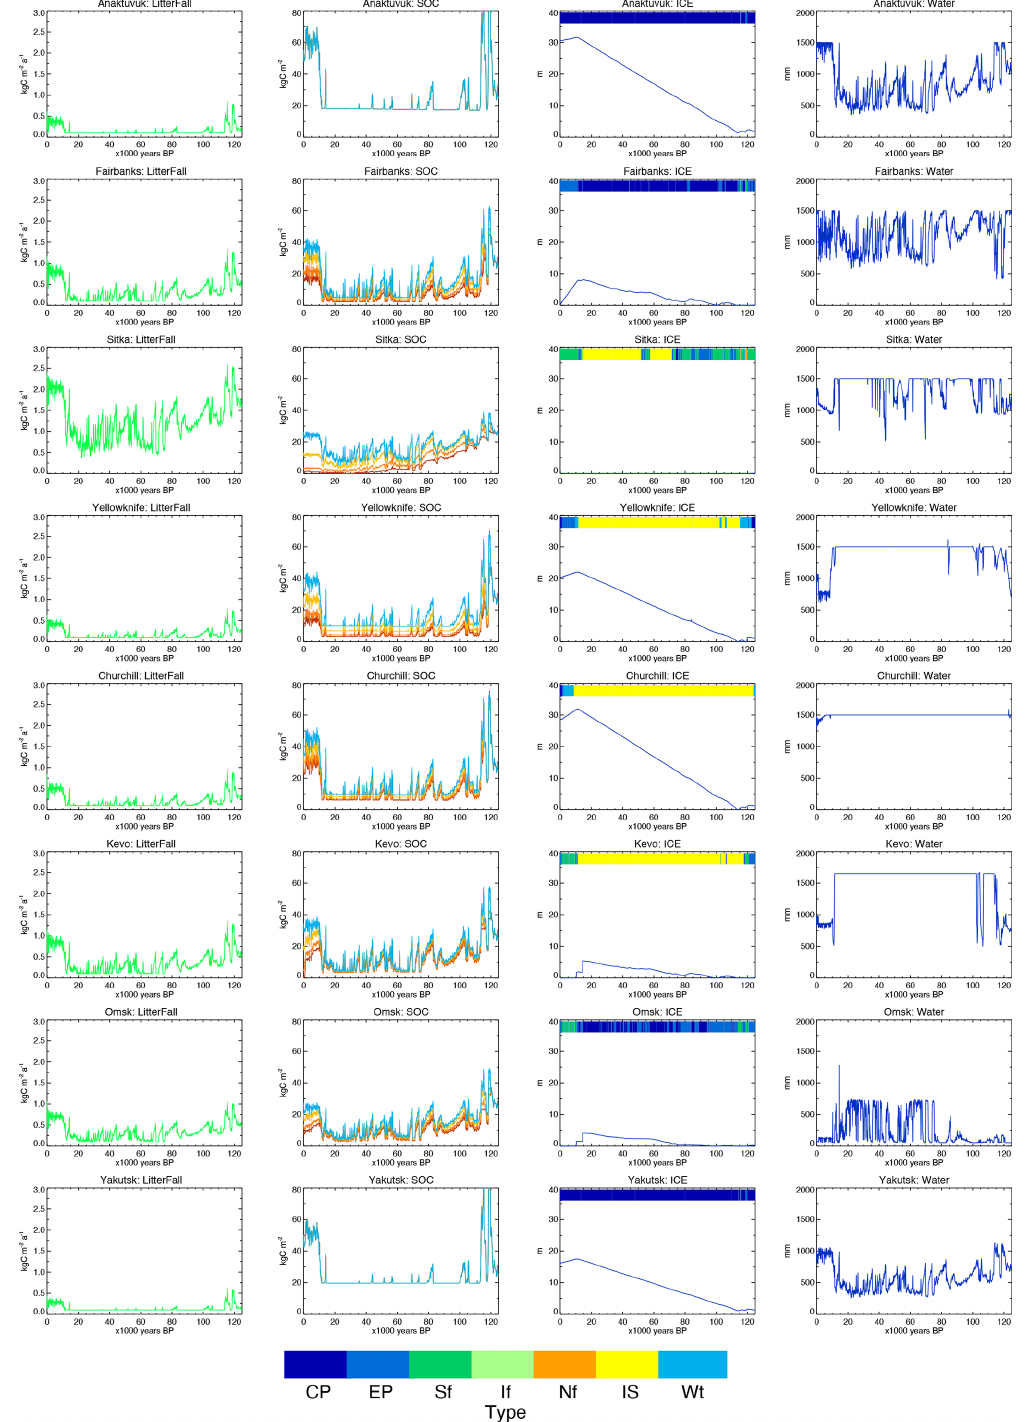
Figure 6. Results of model simulations for the eight circum-Arctic sites shown in Fig. 5. The 125kyr time series of litter fall (in kgCm − 2 ; leftmost column), SOC (in kgCm − 2 ; second from left), ICE (in metres; second from right), and groundwater in liquid phase (water in mm; rightmost column) are shown for different values of τ , relaxation timescale of decomposition rate (red: 4 years, orange: 20 years, yellow: 100 years, blue; 500 years). The legend shows land cover types for continuous permafrost (CP, deep blue), discontinuous permafrost (EP, blue), seasonally freezing ground (Sf, green), intermittently frozen ground (If, pale green), no freezing (Nf, orange), ice sheets (IS, yellow), and water body (Wt, pale